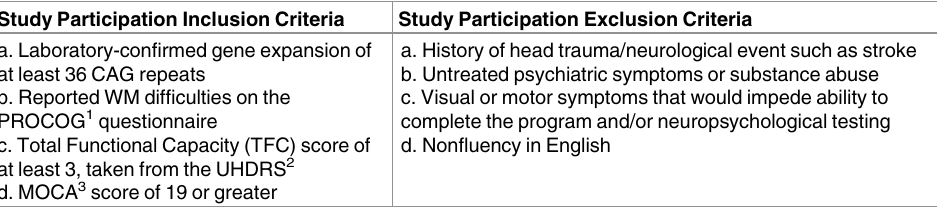
Table 1. Participant inclusion and exclusion